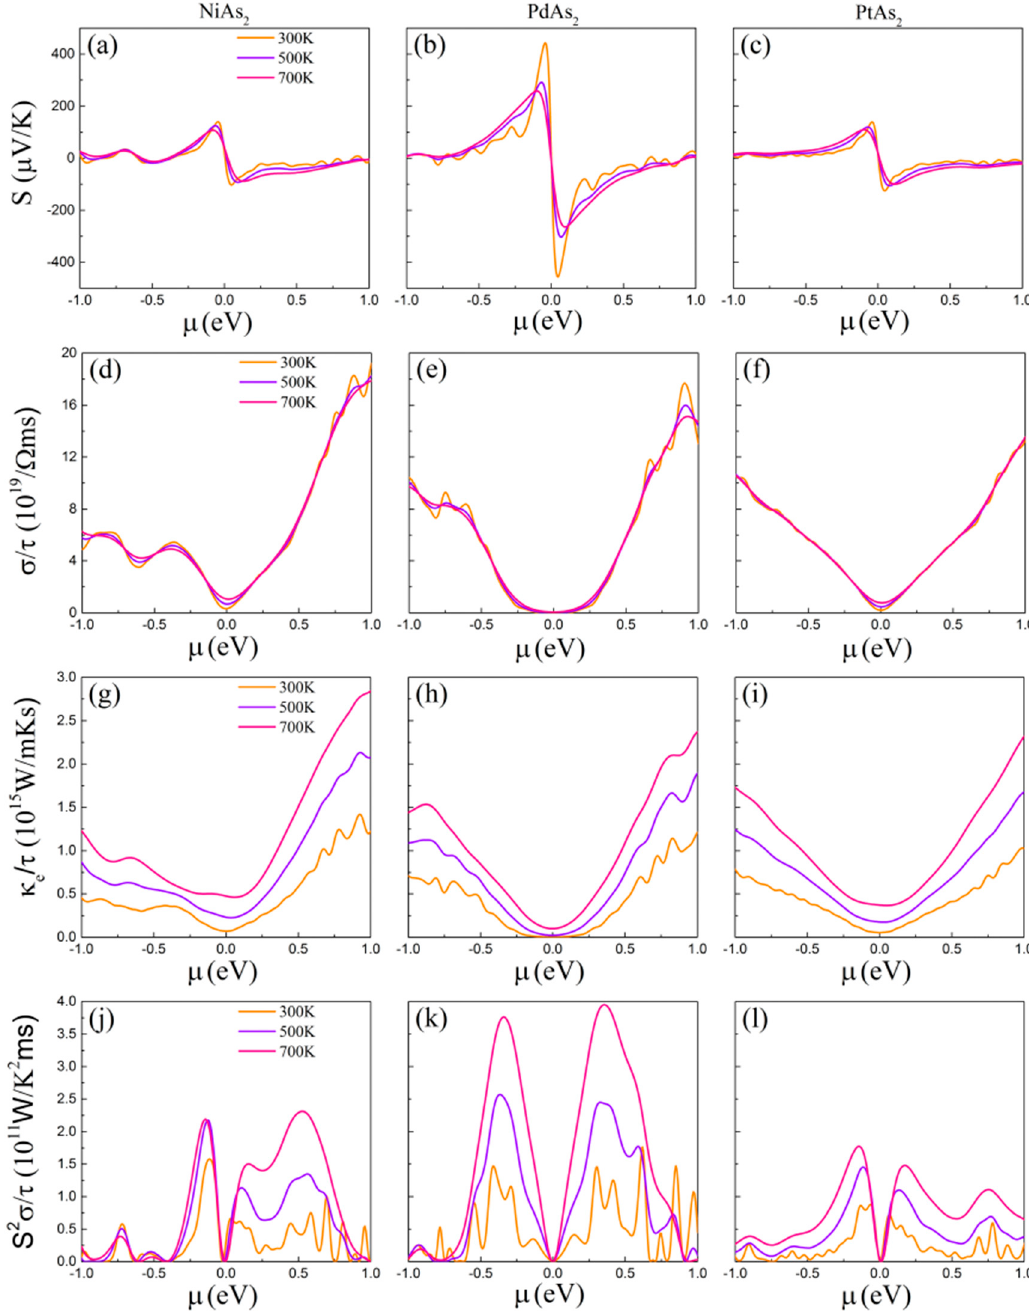
Figure 3. ( a – c ) Seebeck coefficients, ( d – f ) electrical conductivity, ( g – i ) electronic thermal